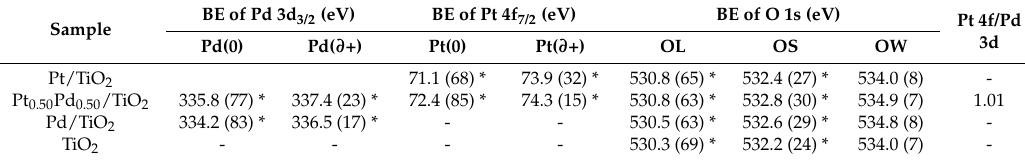
Table 2. Binding energies and surface metallic compositions for the TiO 2 nanowires decorated